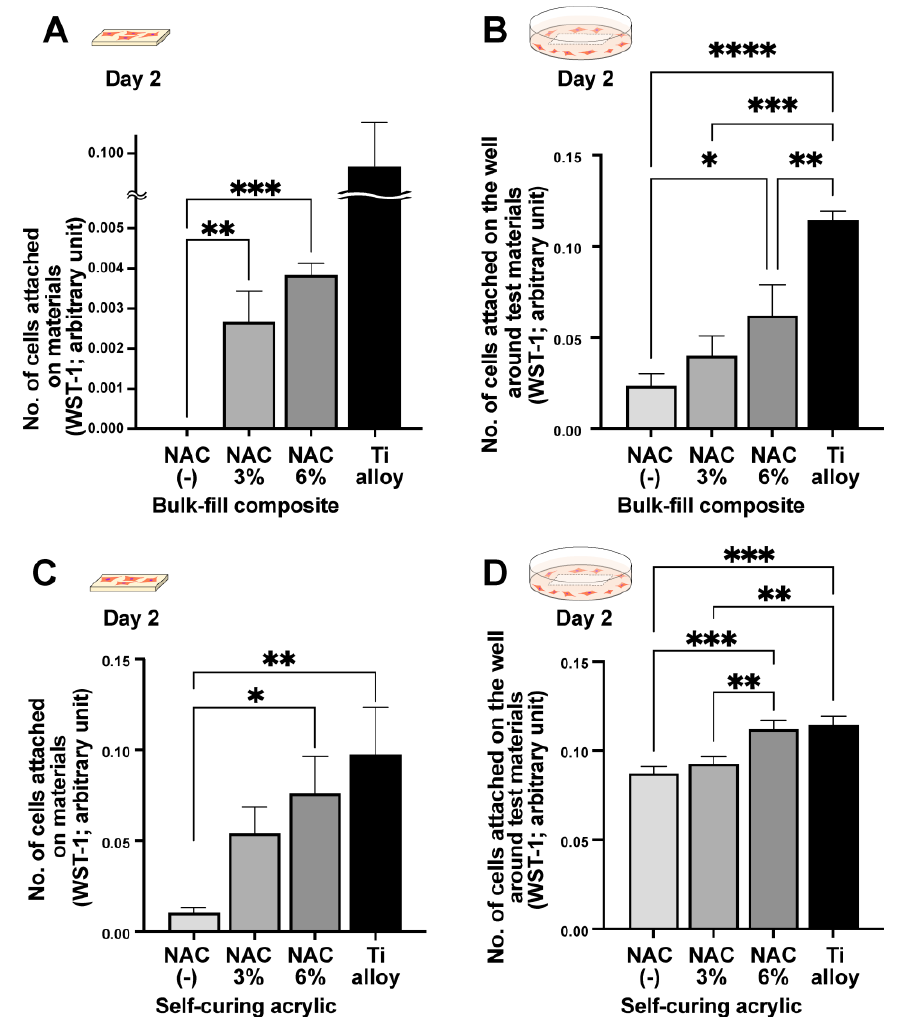
Figure 3. NAC-mediated improvements in material biocompatibility. NAC was impregnated into the materials at two different concentrations. Results of WST-1 assays performed on day two to quantify the number of cells attaching to bulk-fill composite ( A ) and to the well around bulk-fill composite ( B ). The number of cells attaching to self-curing acrylic ( C ) and to the well around self-curing acrylic ( D ): * p < 0.05, ** p < 0.01, *** p < 0.001, and **** p < 0.0001.